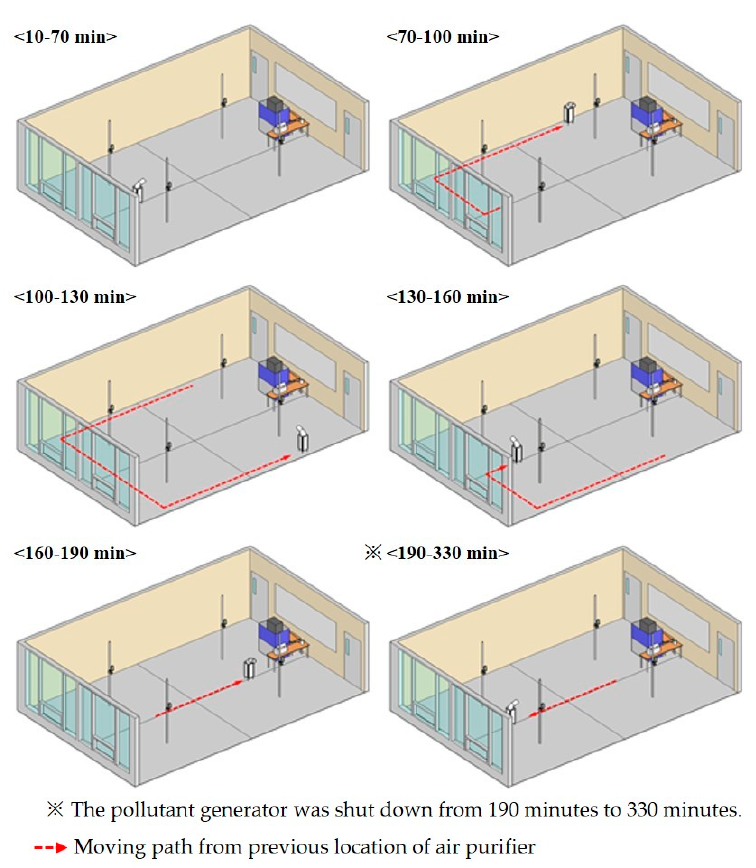
Figure 12. Moving path of the air purifier that controls zones.